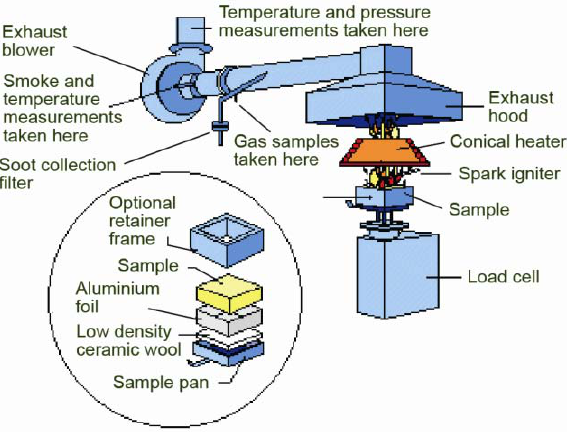
Fig. 1. The general view of a cone calorimeter The samples of real board thickness were cut